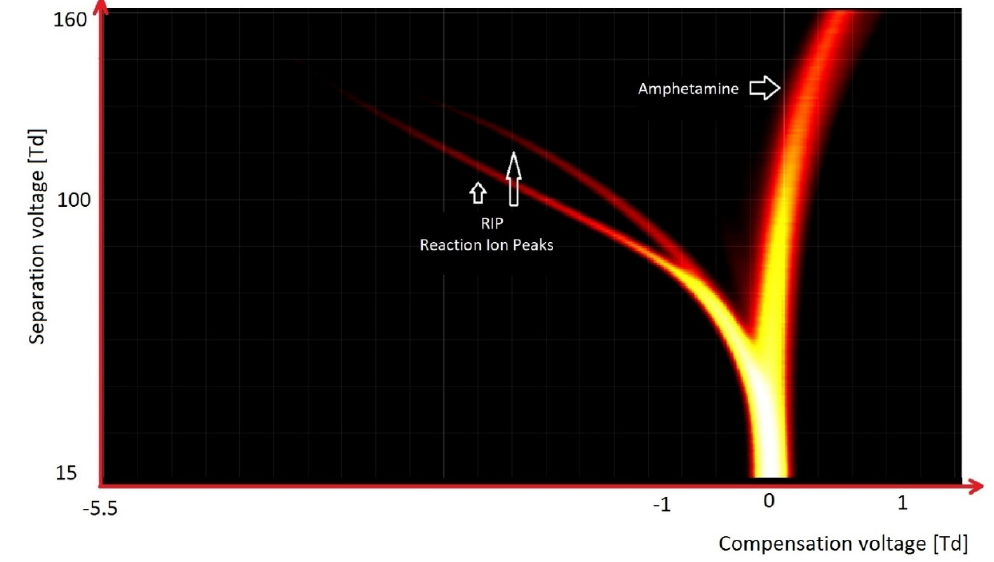
Figure 17. DMS spectrogram of amphetamine sulfate.